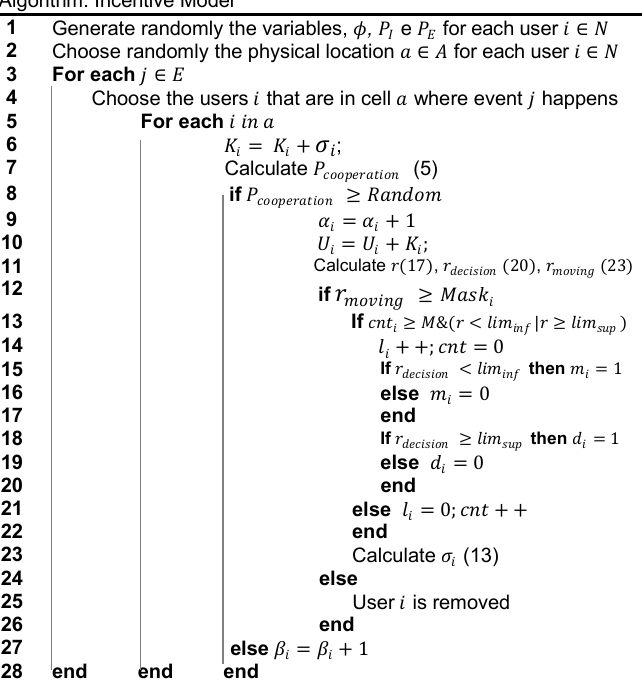
Figure 11. Pseudocode of the incentive mechanism.